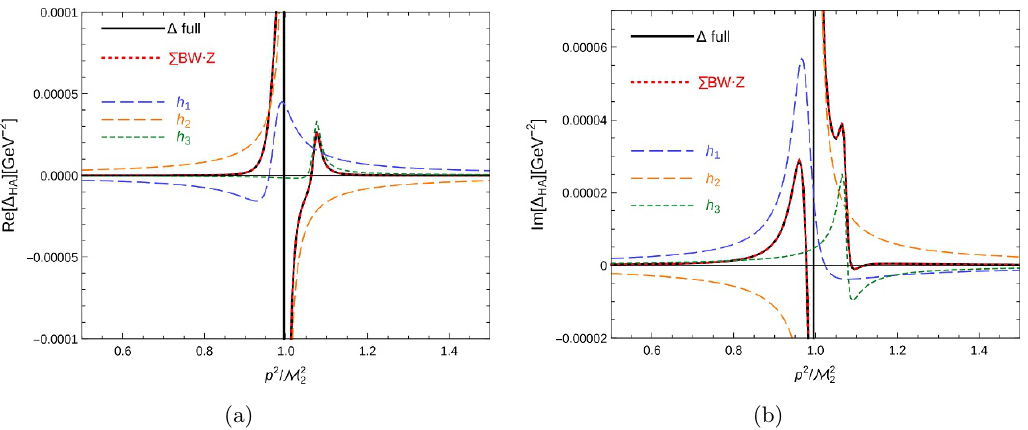
Figure 6 . O(cid:11)-diagonal propagator (cid:1) HA ( p 2 ) depending on the complex momentum p 2 around M 2 with p 2 = M 2 = 0 : 5 : : : 1 : 5. (a) real part, (b) imaginary part. Labelling as in (cid:12)gure 2